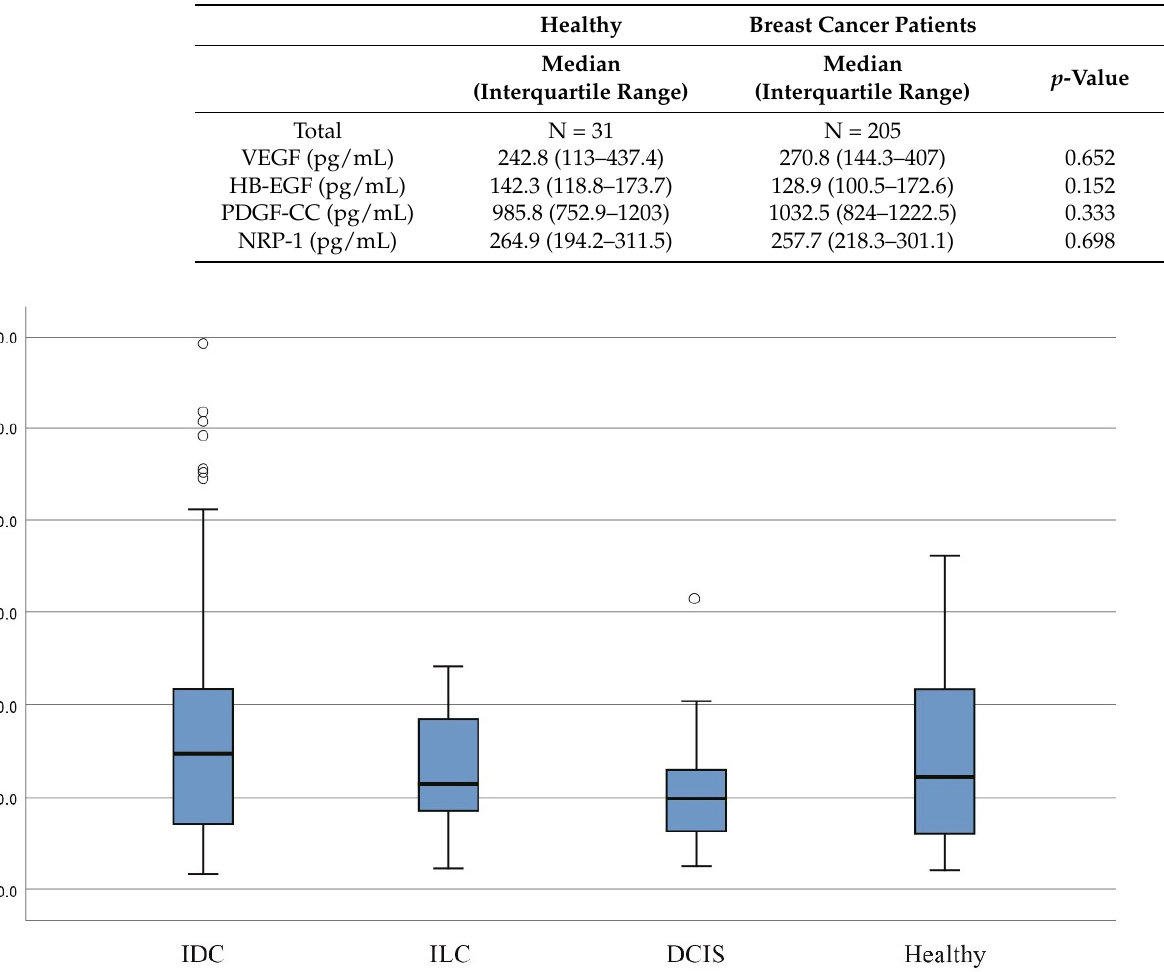
Table 1. Median concentrations (interquartile range) of VEGF, HB-EGF, PDGF-CC and NRP-1 in the serum of the examined patients and healthy women.